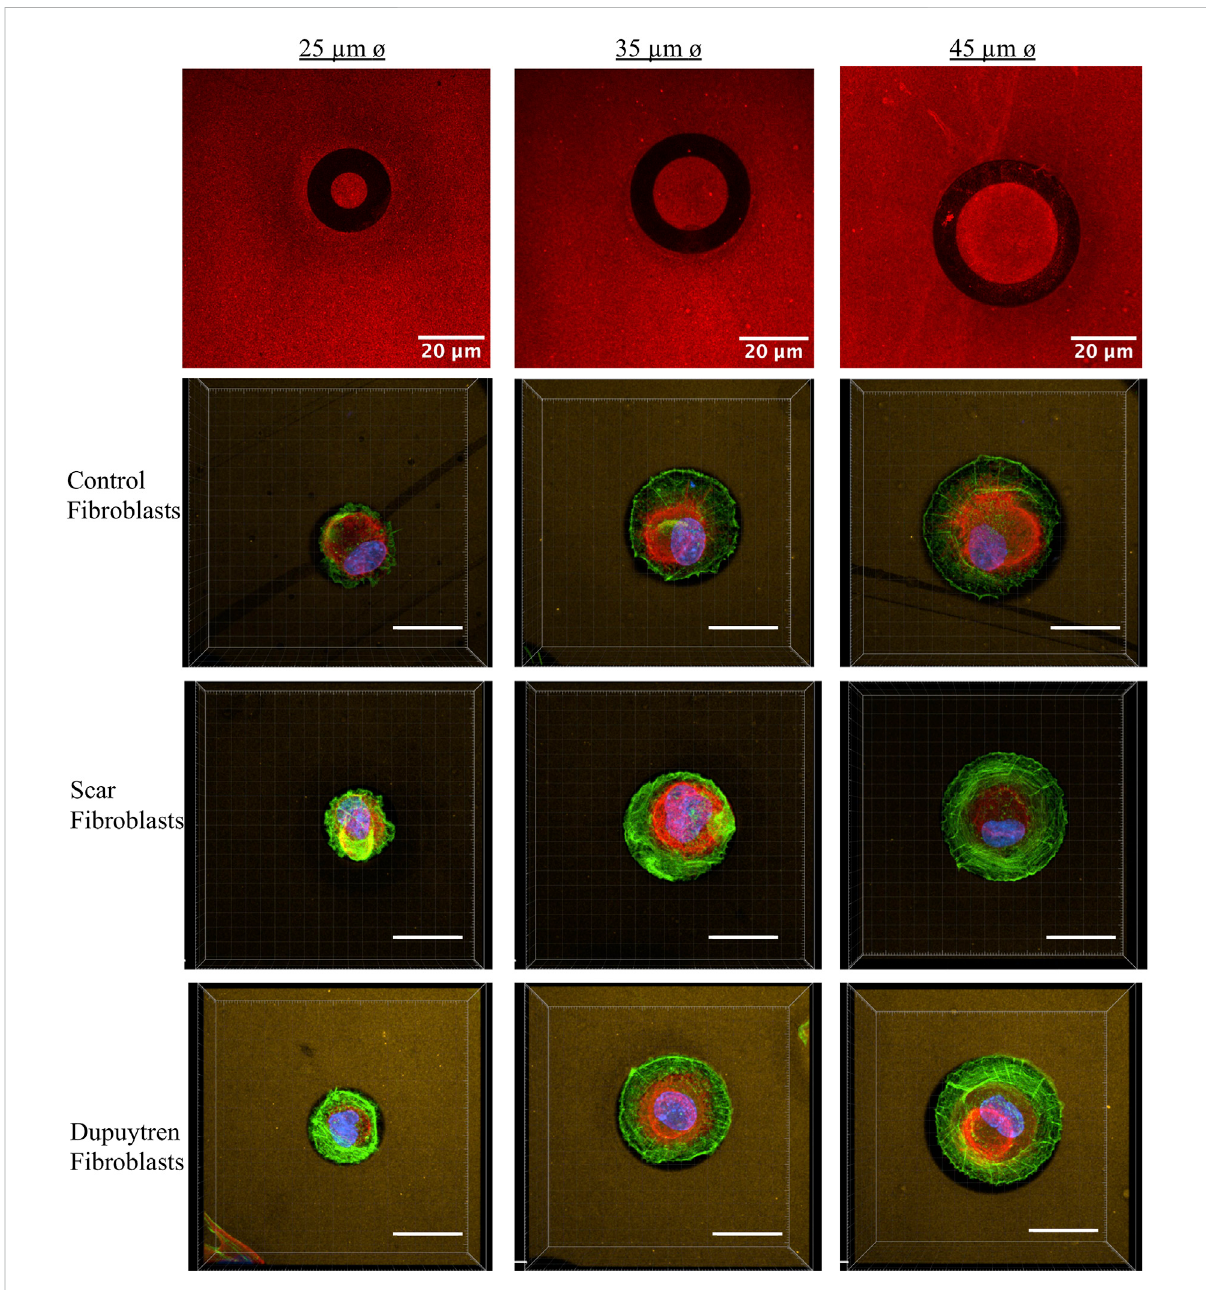
FIGURE 2 Examples of individual fi broblasts plated on 25-, 35-, and 45- μ m-diameter circular micropatterns (left to right). The fi rst row represents fi bronectin circular-shaped micropatterns in black. The following rows represent fl uorescence microscopy images of each type of fi broblasts in which the actin fi bers are labeled in green, vimentin in red, and nuclei in blue. Three-dimensional view videos are available in the Supplementary